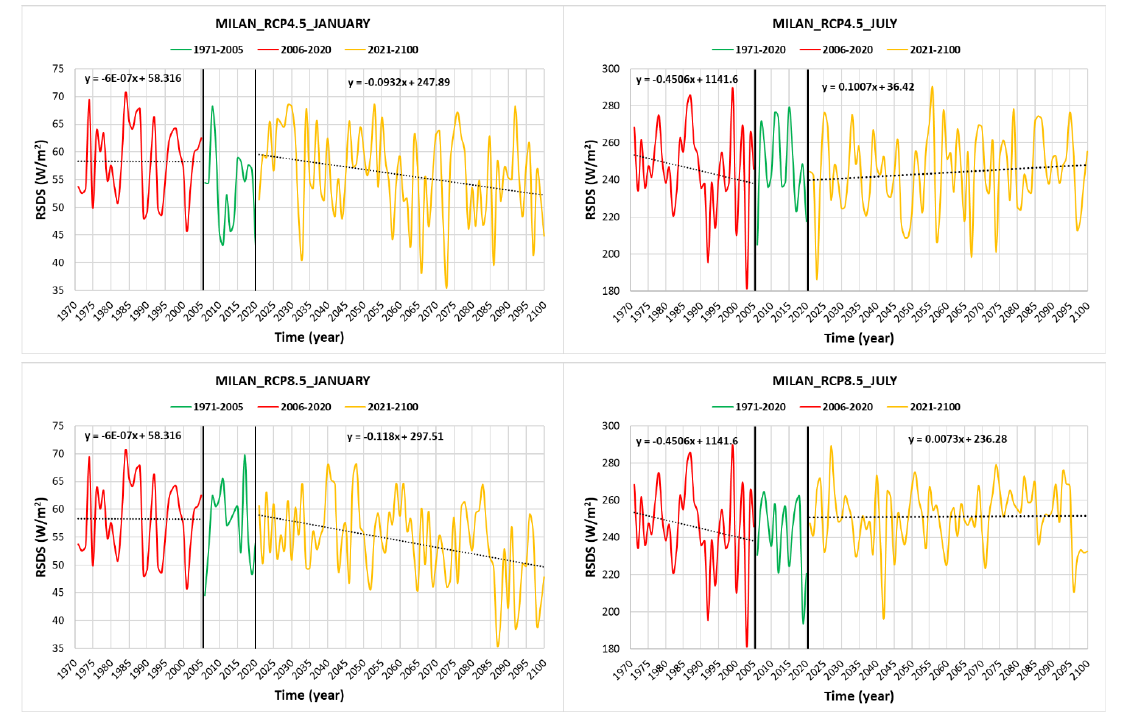
Figure 5. Milan’s monthly average hourly RSDS variation in January ( left ) and July ( right ) from 1971 to 2100. ( Top ): RCP4.5, ( bottom ): RCP8.5.